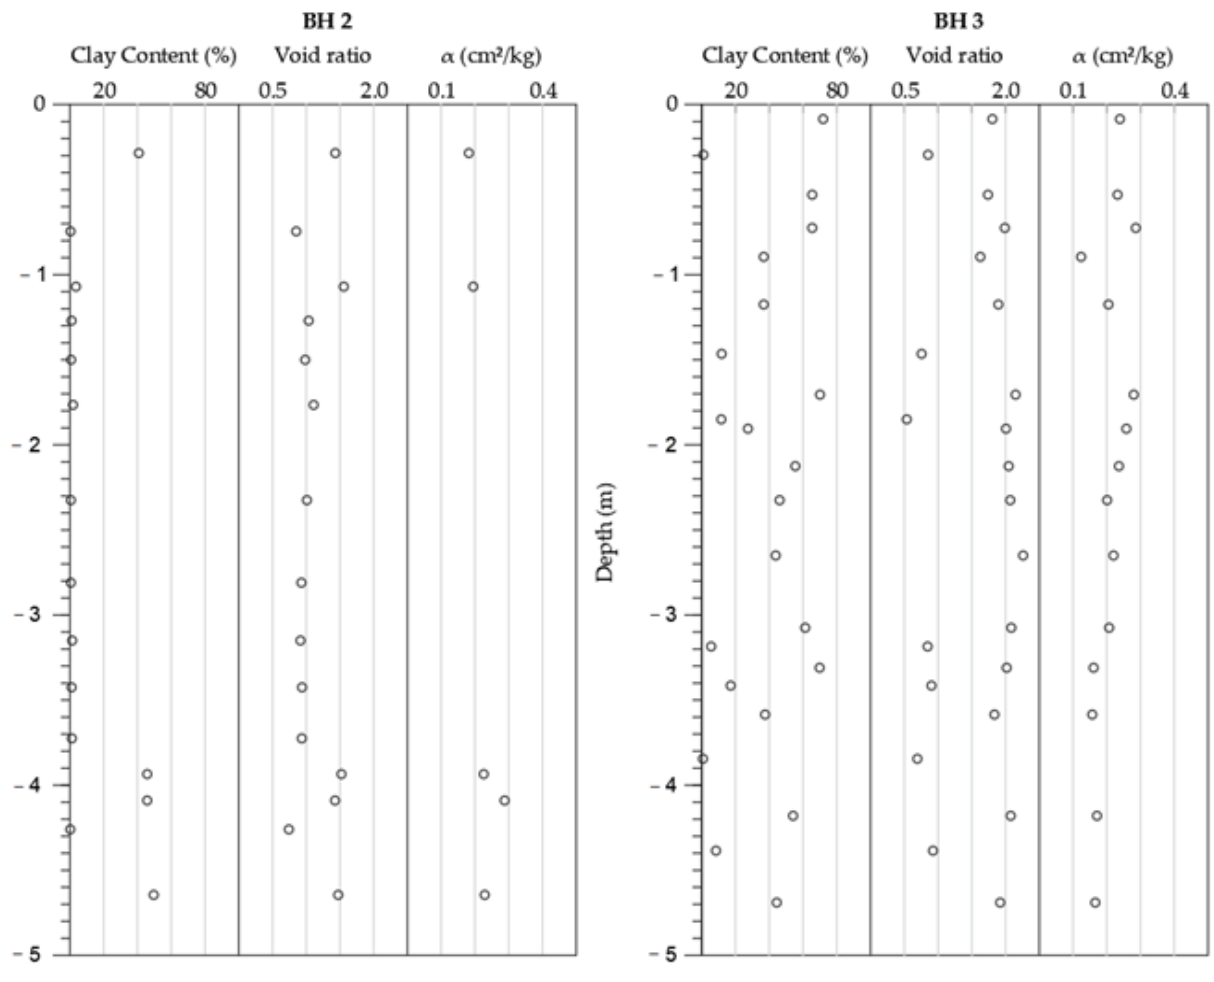
Figure 14. Sediment consolidation parameters consisting of clay content (%), void ratio, and compressibility coefficient ( α ) at BH2 and BH3.